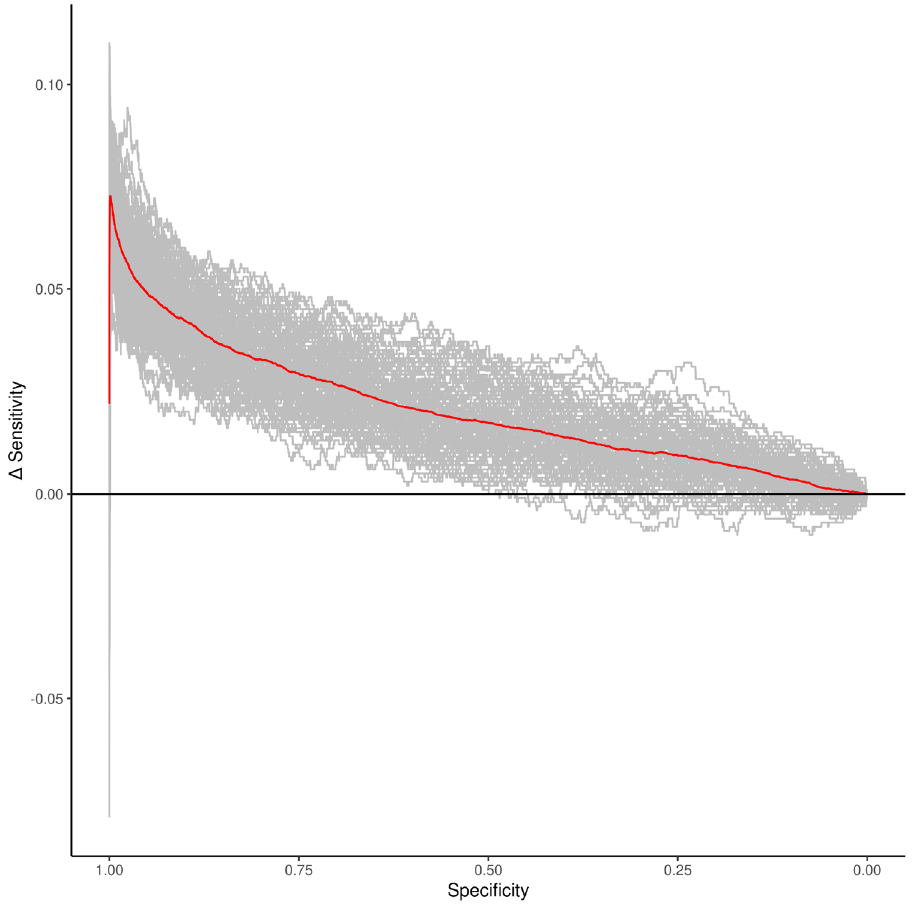
Figure 2. Difference in sensitivity (between fastGWA-PGS-LDpred2 and fastGWA) as a function of specificity for 100 simulations of a continuous trait with narrow-sense heritability of 0.5 and 1000 causal variants in 100,000 individuals. The specificity (x-axis) is discretized in bins of size 0.0001. Each grey line shows the results of one simulation. The red line shows the mean difference over all